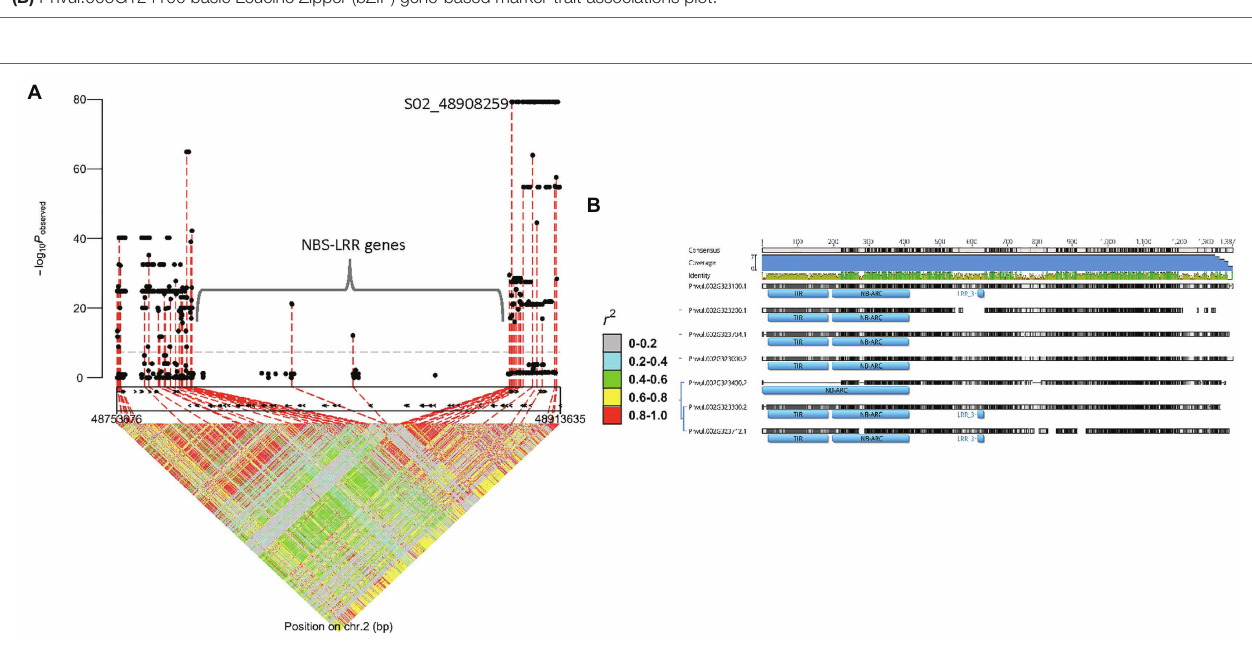
FIGURE 4 | Regional association plot displaying GWAS results and candidate genes for I gene: (A) I gene regional marker-trait associations and linkage disequilibrium plots, and (B) alignment of the amino acid sequences of NBS-LRR cluster